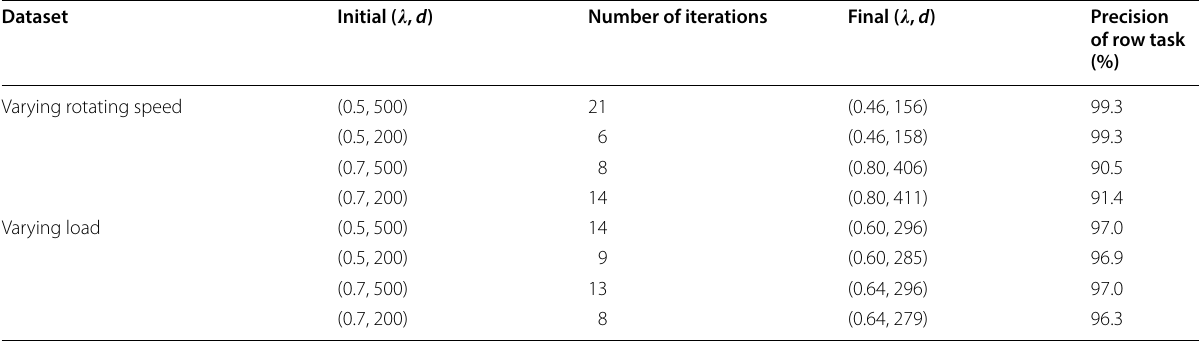
Table 10 Regulator results of gradient ascent algorithm